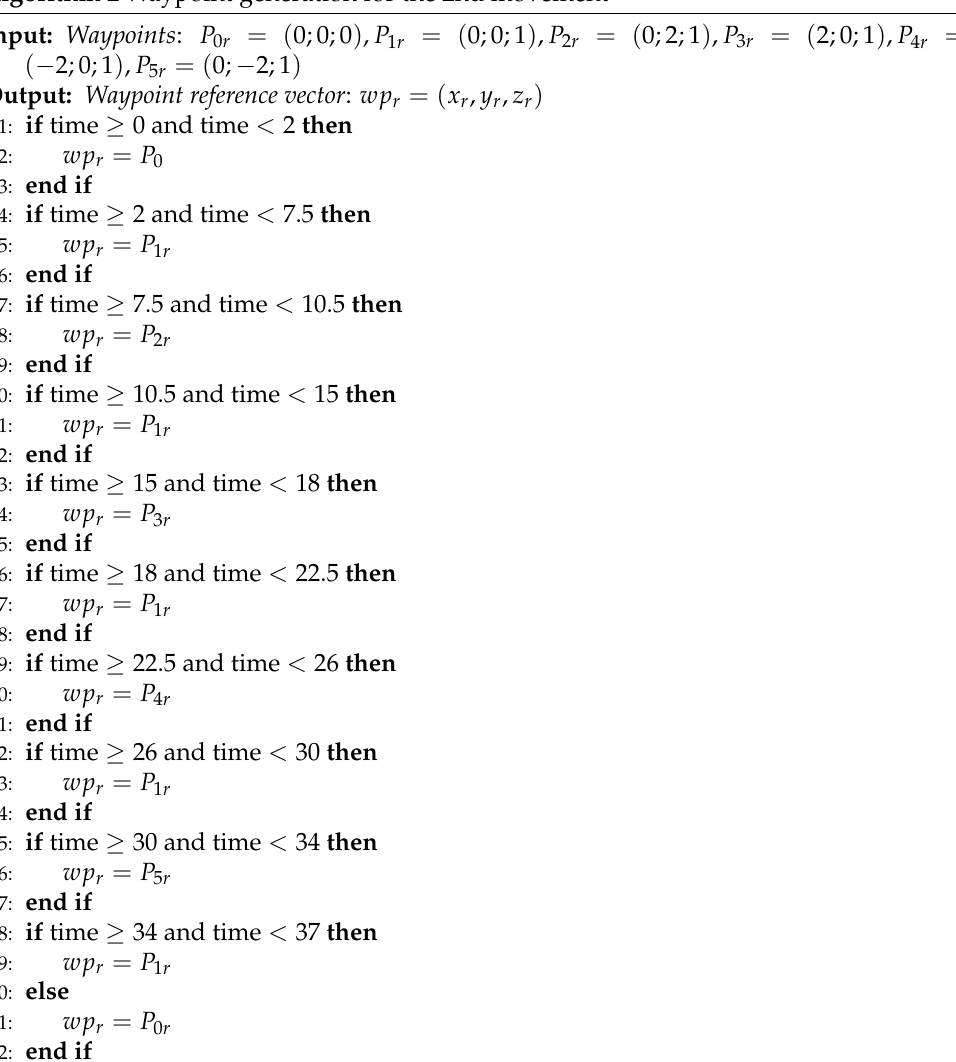
Algorithm 2 Waypoint generation for the 2nd